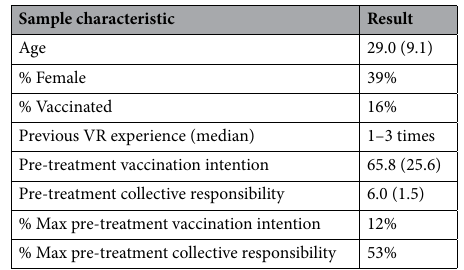
Table 1. Characteristics of the analyzed study sample ( n = 222 ). Continuous variables are summarized as mean (standard deviation). Last two rows are % of respondents who had maximum values on the outcome measures before receiving any